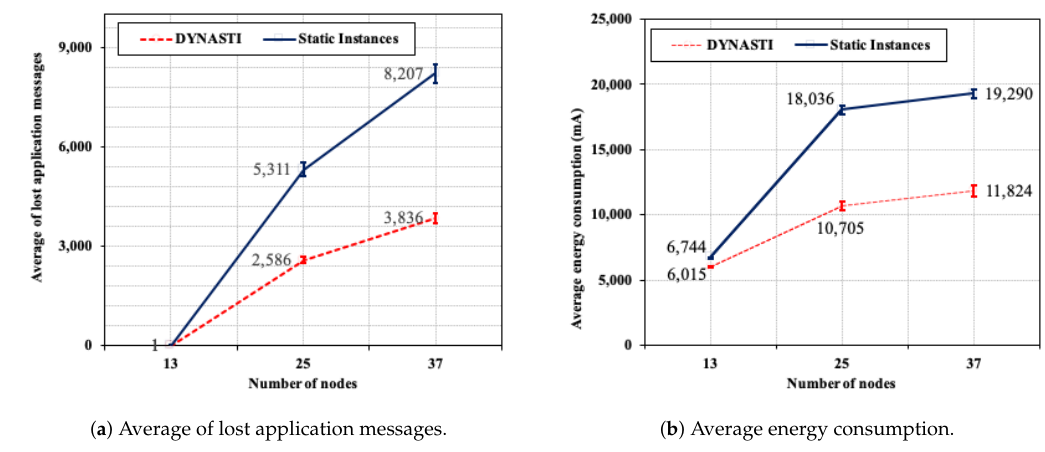
Figure 9. Average of lost application messages and average energy